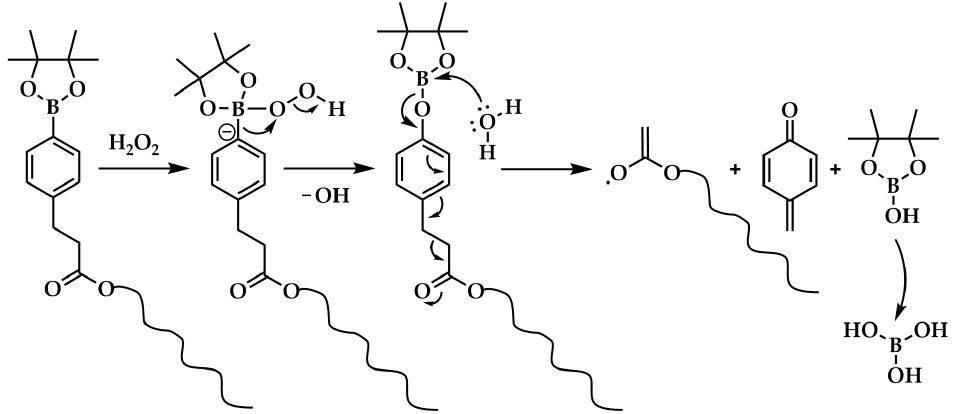
Figure 7. Mechanism of arylboronate oxidation under the influence of hydrogen peroxide.